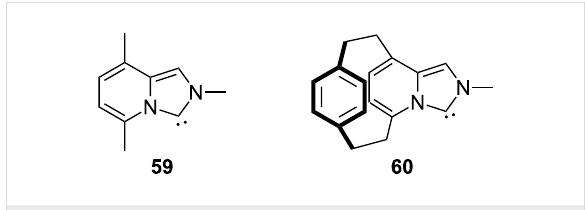
Figure 2: NHC ligands with different π -acceptor properties